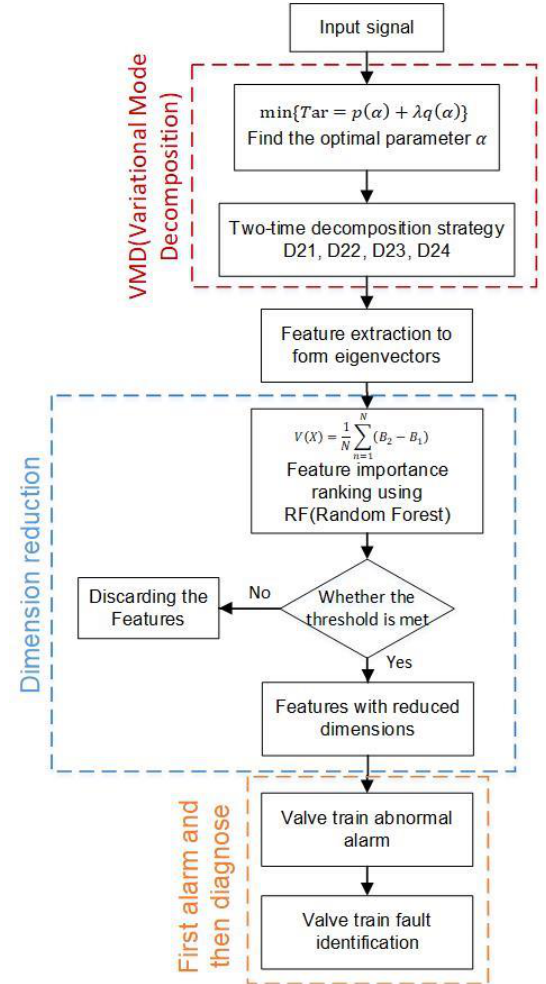
Figure 6. Fault diagnosis process.